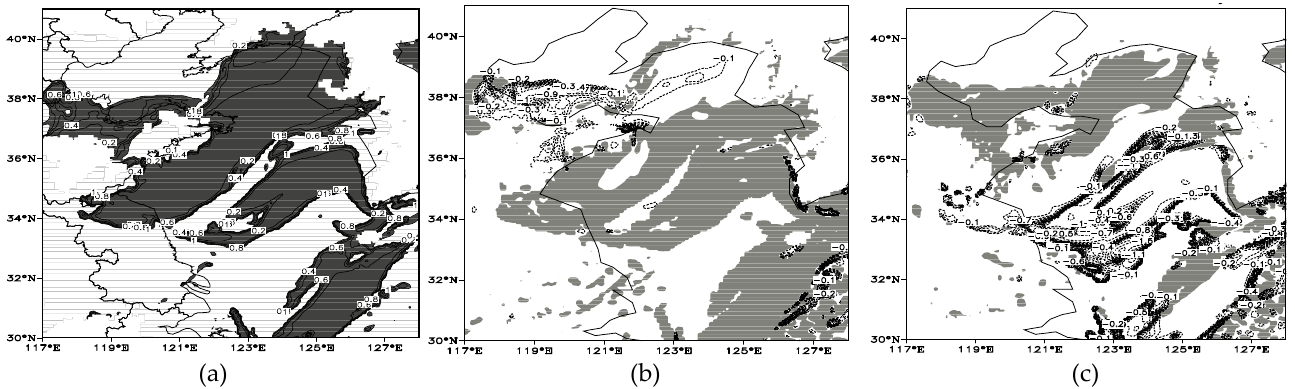
Figure 3. The difference in simulated visibility at 08 UTC 21 January 2013: ( a ) Exp.1, ( b ) Exp.2 minus Exp.1, and ( c ) Exp.3 minus Exp.1. Shading indicates positive difference, dashed line represents negative difference, and square area is the average range of the selected area (units: km).